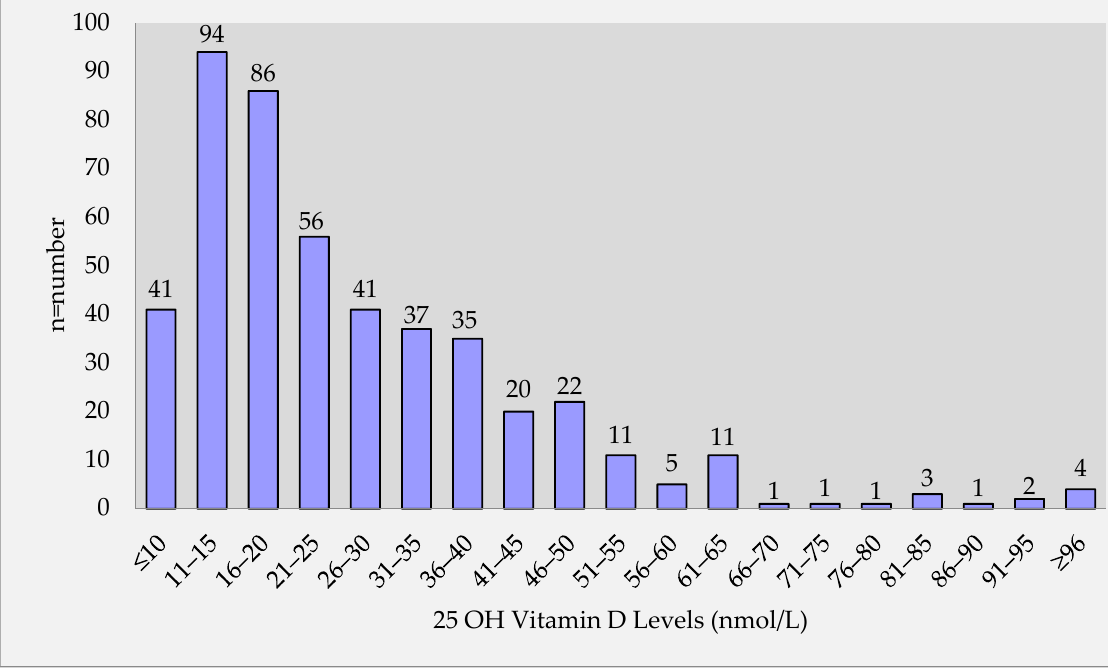
Figure 1. Distribution of patients according to vitamin D levels.